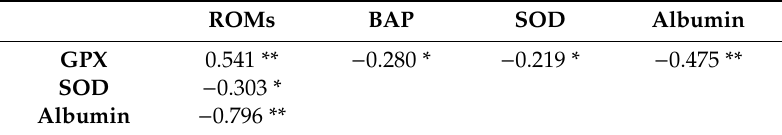
Table 3. Pearson correlation coe ffi cients and probabilities significance of oxidative status biomarkers in late lactation